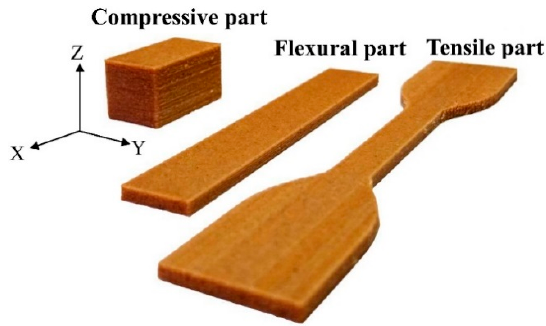
Figure 2. Appearances of the FDM-printed WPC parts for the tensile test, flexural test, and compressive test.